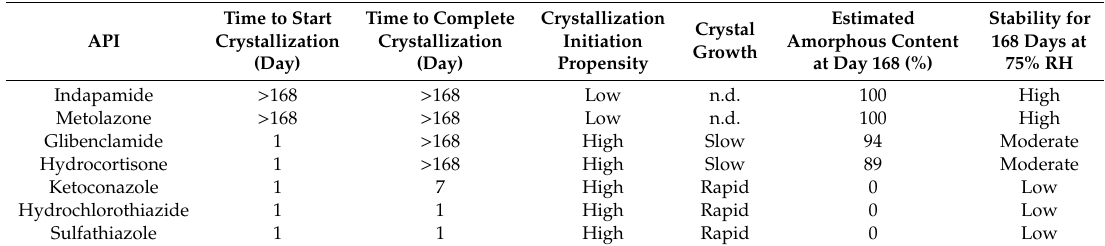
Table 1. Stability profile of spray-dried amorphous active pharmaceutical ingredients (APIs) upon exposure to 75% RH at 25 ◦ C for 168